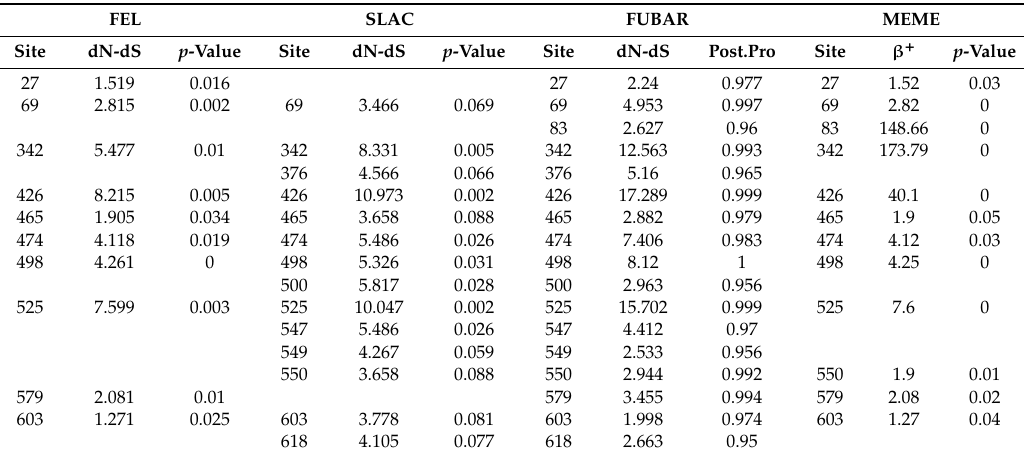
Table 2. Selection analysis of PPV7 NS1 coding